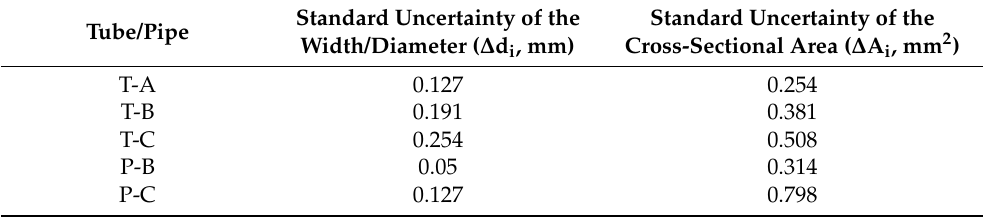
Table 3. Standard uncertainty of the width and diameter and resulting cross-sectional area of the tubes and pipes. See Table 1 for manufacturer’s information from which the inside width or diameter was collected as well as the respective tolerance of the